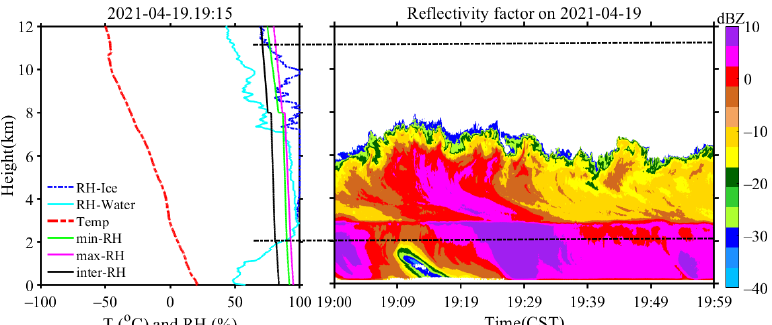
Figure 7. Precipitation cloud detected by the radiosonde and MMCR on 19 April 2021 (radiosonde temperature and RH profile ( left ), reflectivity factor THI from the MMCR ( right )).